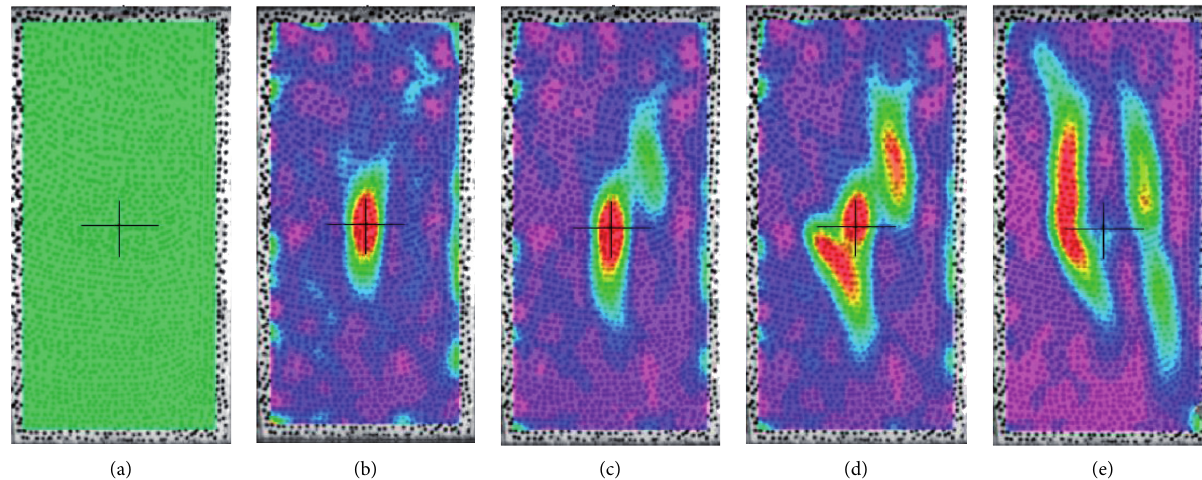
Figure 16: Stress field developed at different times for the jointed specimen with α � 90 ° . (a) t � 0s. (b) t � 300s. (c) t � 410s. (d) t � 455s. (e) t �